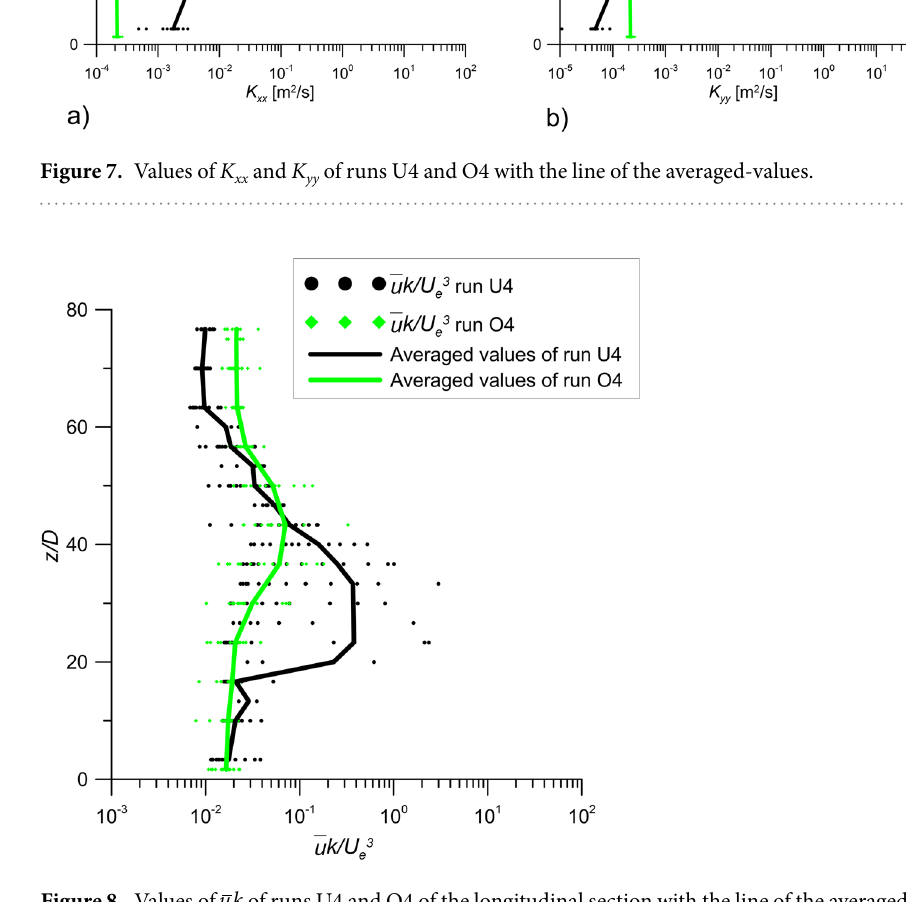
Figure 8. Values of uk of runs U4 and O4 of the longitudinal section with the line of the